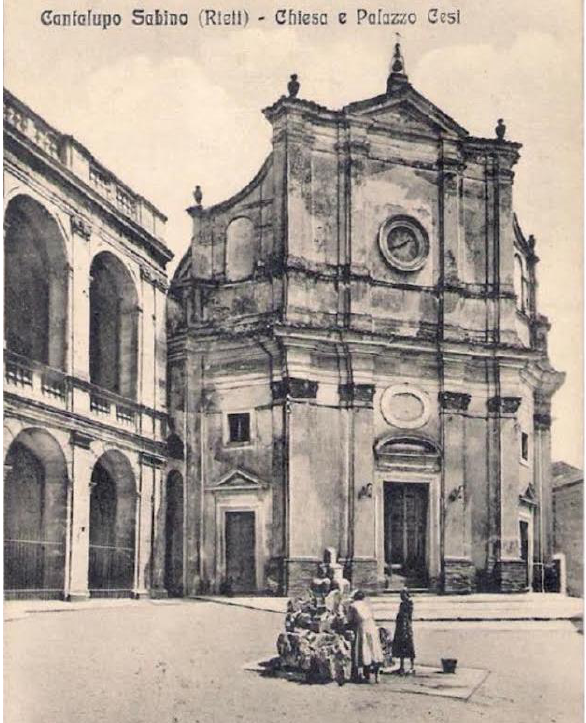
Figure 1. Historical photo of the church’s facade of Maria SS. Assunta in Cielo, located in Cantalupo in Sabina